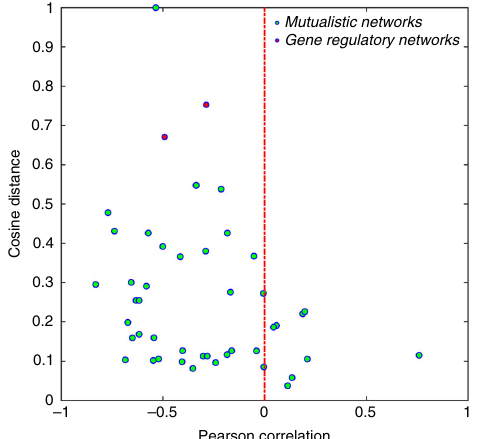
Fig. 5 Pearson correlation and cosine distance between linear and nonlinear control importance. The abscissa and ordinate correspond to the values of Pearson correlation and cosine distance, respectively, between linear and nonlinear control importance. Each green circle corresponds to a real mutualistic network (there are 43 of them) and the two red dots are for the two gene regulatory subnetworks in Fig. 4. If there were a kind of relevance between nonlinear and linear control of the same network, the dots would concentrate in the lower right region of the plane with positive Pearson correlation and a small cosine distance. For most of the empirical networks tested, the dots are in the region of negative correlation with cosine distances below 0.4. For the two gene regulatory subnetworks, not only are the values of the Pearson correlation negative, the cosine distances are also